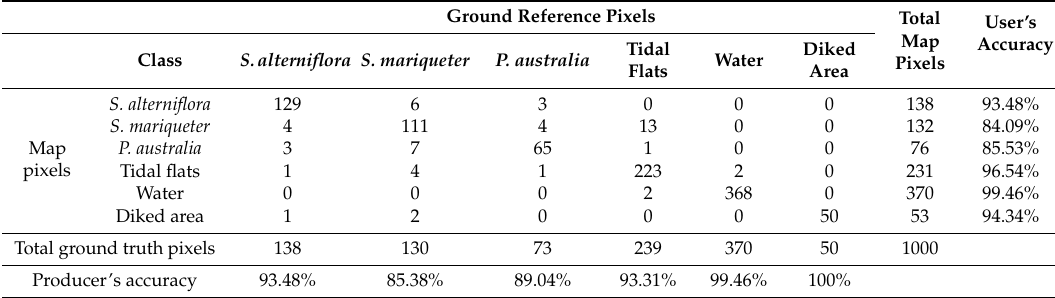
Table 2. Accuracy assessment of supervised classification in Landsat images.